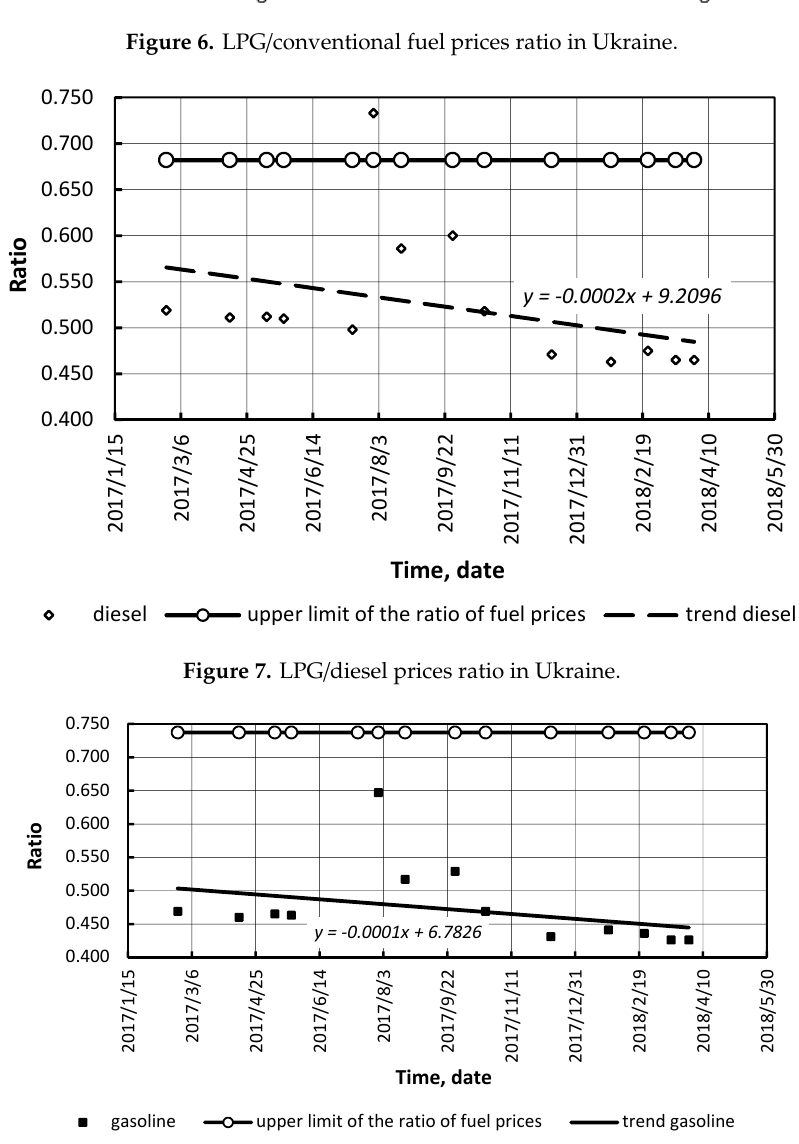
Figure 8. LPG/gasoline prices ratio in Ukraine. Figure 8. LPG / gasoline prices ratio in